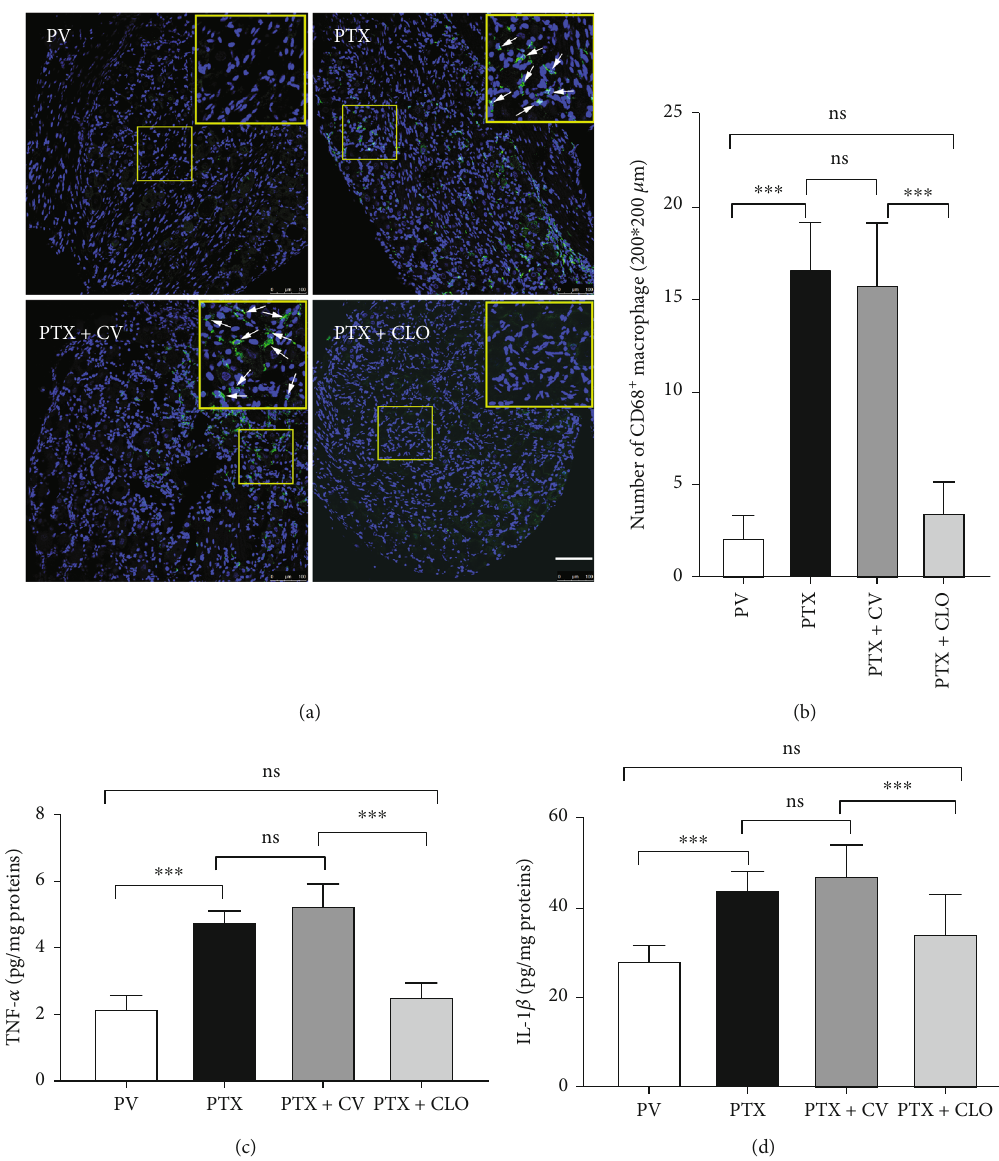
Figure 2: The e ff ect of clodronate disodium liposomes on macrophage in fi ltration and levels of in fl ammatory cytokines in the DRG of rats with PIPN at day 14. (a) Microphotographs of CD68 + macrophages assayed by immuno fl uorescence in the DRG on day 14 ( scale bar = 100 μ m ). (b) Number of CD68 + macrophages. Three 200 μ m × 200 μ m areas were randomly selected to count the number of CD68+ cells in one slice and the average value was calculated. (c-d) Levels of in fl ammatory cytokines in the DRG evaluated by ELISA. Data are expressed as the mean ± SD ( n = 6 in each group). The results were analyzed using one-way ANOVA followed by the LSD post hoc test. Asterisks indicate a signi fi cance between two groups at ∗∗∗ P < 0 : 001 ; ns: no signi fi cant di ff erence between two